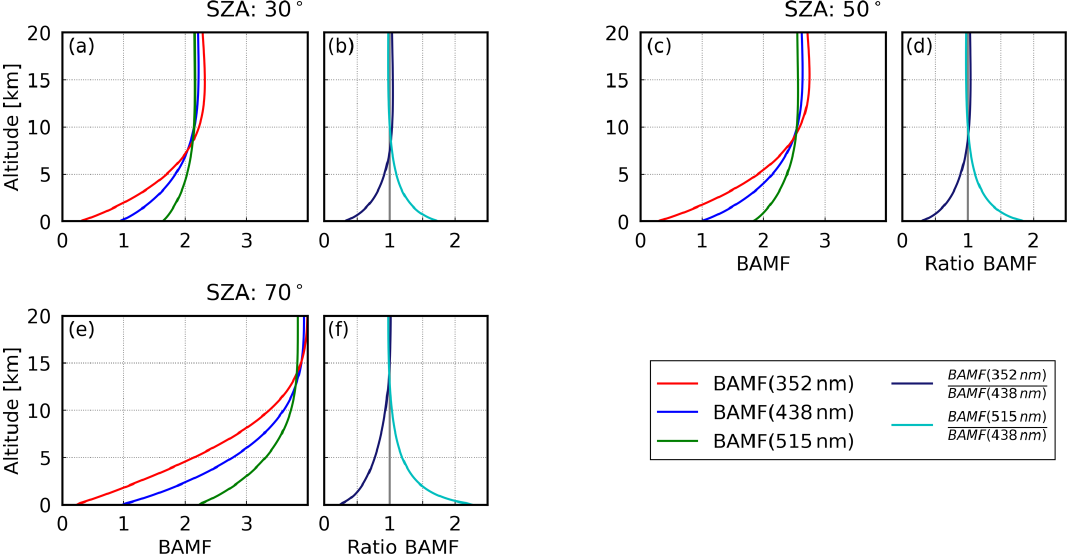
Figure 1. BAMF for UV (red line), green (green line), and blue (blue line) spectral range and the ratio of UV and green BAMFs calculated with the radiative transfer model SCIATRAN. BAMFs converge at higher altitude (not shown). The BAMFs are calculated for 352nm (UV), for 438nm (vis blue ), and for 515nm (vis green ) at (a, b) 30 ◦ , (c, d) 50 ◦ , and (e, f) 70 ◦ SZA. A surface spectral reflectance of 0.04 (352nm), 0.06 (438nm), and 0.09 (515nm) representative for bare soil is